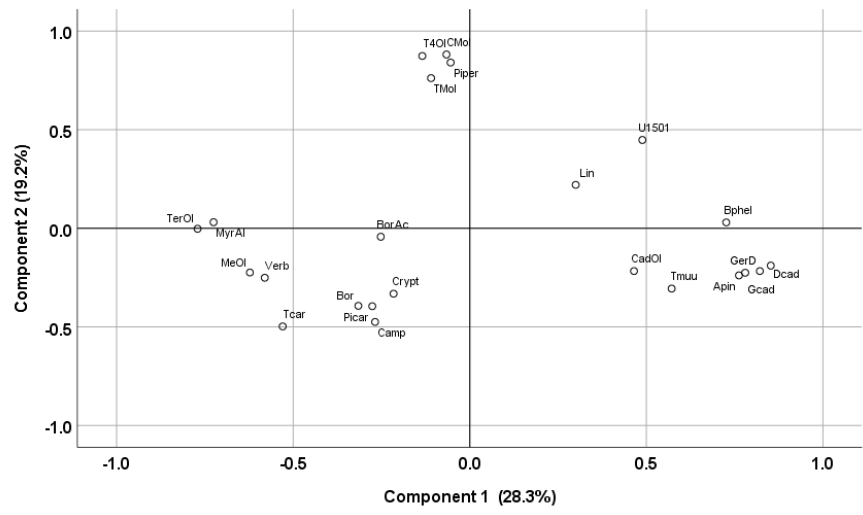
Figure 3. Hydrolate volatile compounds loading on the first two axes of a principal component analysis of P. cembra hydrolates.